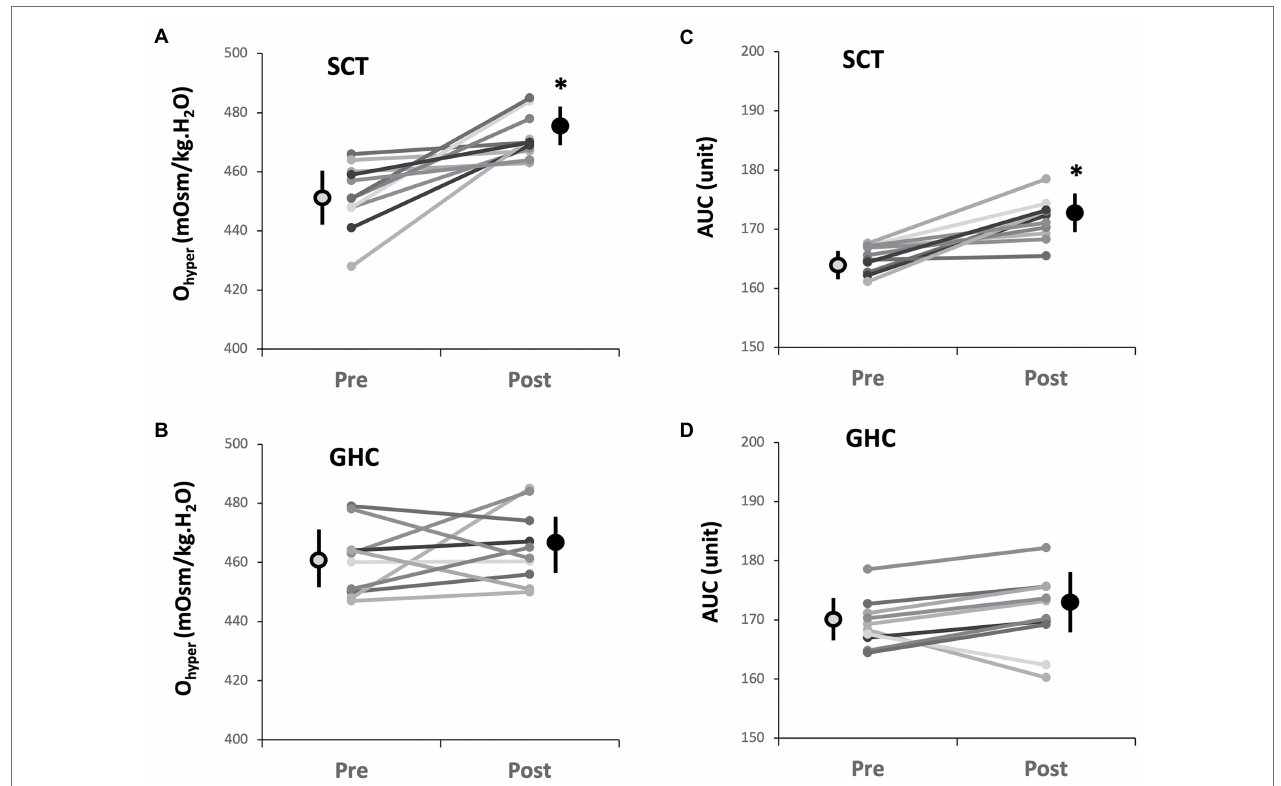
FIGURE 4 | Effect of SCT and GHC on erythrocyte osmotic deformability [ (A) and (B) O hyper ; (C) and (D) AUC] in PAD. O hyper , osmolality in the hypertonic region corresponding to 50% maximal elongation index (EI max ); AUC, area under the individual EI-osmolarity curve. Pre, pre-intervention; Post, post-intervention. Values are mean ± SD. * p < 0.05, pre or